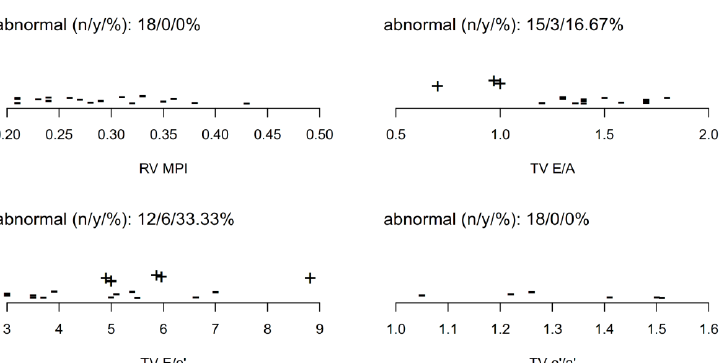
Figure 4. Distribution of raw data for TAPSE, RV longitudinal strain, TV S’, RV-FAC, RV MPI, TV E/A, TV E/e’, and TV e’/a’ . “−“ = parameter within age-dependent reference range; “+” = parameter outside of age-dependent reference range (“abnormal”). With growing age, the proportion of patients without abnormal RV function decreases (Figure 5a–e).